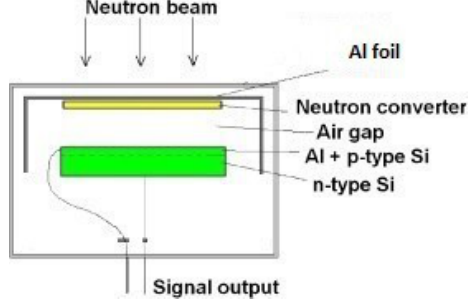
Figure 2. The scheme of 6 Li + Si detector [8].